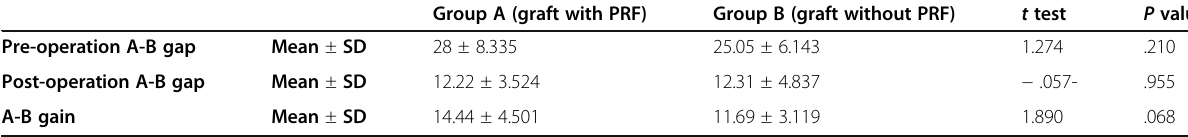
Table 4 Comparison between group A and group B regarding preoperative ABG, postoperative ABG, and A-B